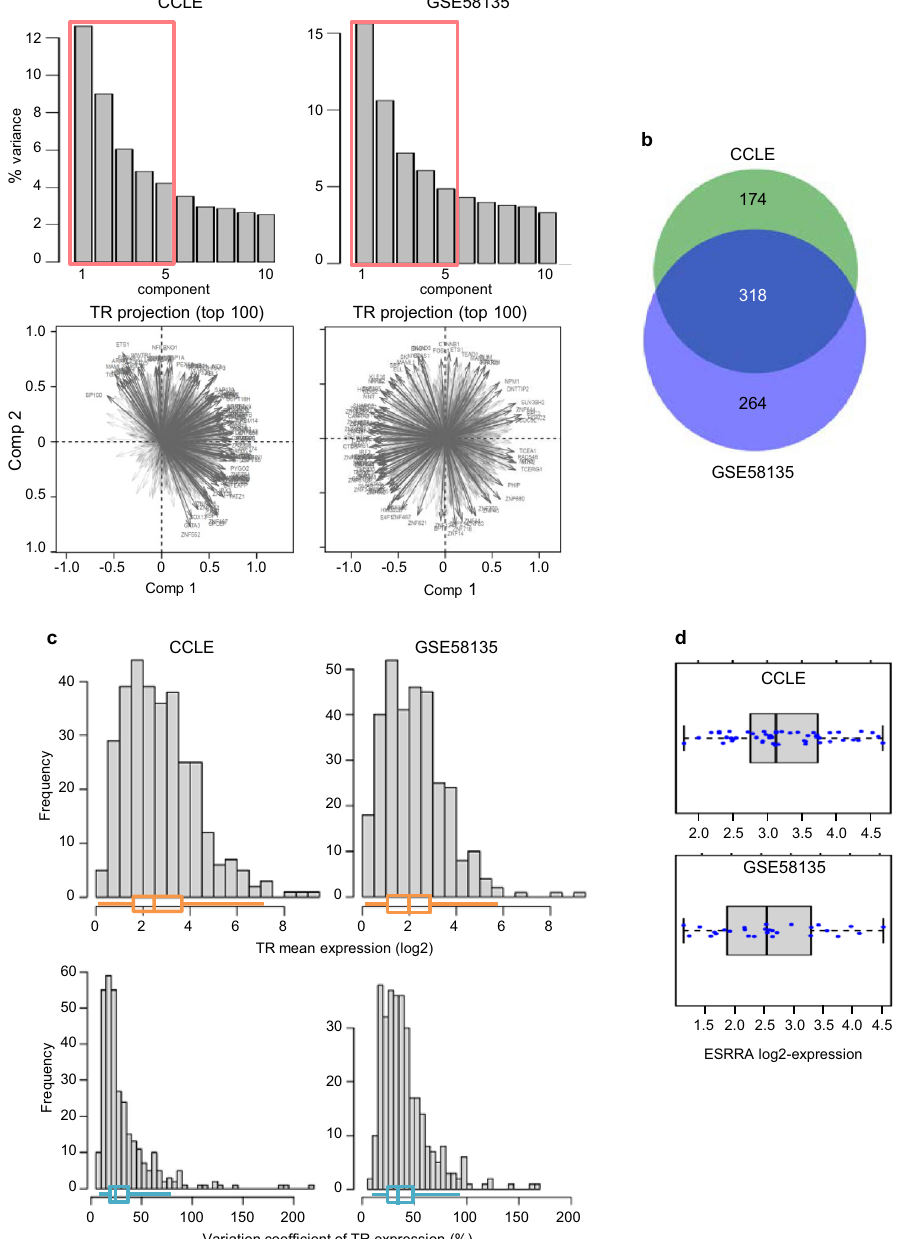
Figure 2. Identification of a reduced set of TRs. ( a) PCA (FactoMineR R package) on TR log2-expression across cell lines in each dataset. In the upper panels the scree plots show the selection of the 5 first principal components (37 to 44% of the total variance). The lower panels show the projection of the 50 best TRs taken as variables on the 2 first principal axes in each dataset. For each dataset, absolute value of correlation coefficient > 0.5 with each of the axes was taken as meaningful. ( b) Venn diagram showing the selected TRs common to the 2 datasets. (c) Distributions of mean expression and of expression variation coefficient of the 318 selected TRs across cells in each dataset associated with boxplots. They show moderate expression of the majority of TRs with variation coefficient across cells mostly between 20 and 50% (inter-quartile range). ( d) Boxplots showing ESRRA expression and variability in the BC cells of CCLE and GSE58135 datasets. ( c, d) Expression is log2 of upper-quartile normalized TPM (for CCLE) or FPKM (for GSE58135)